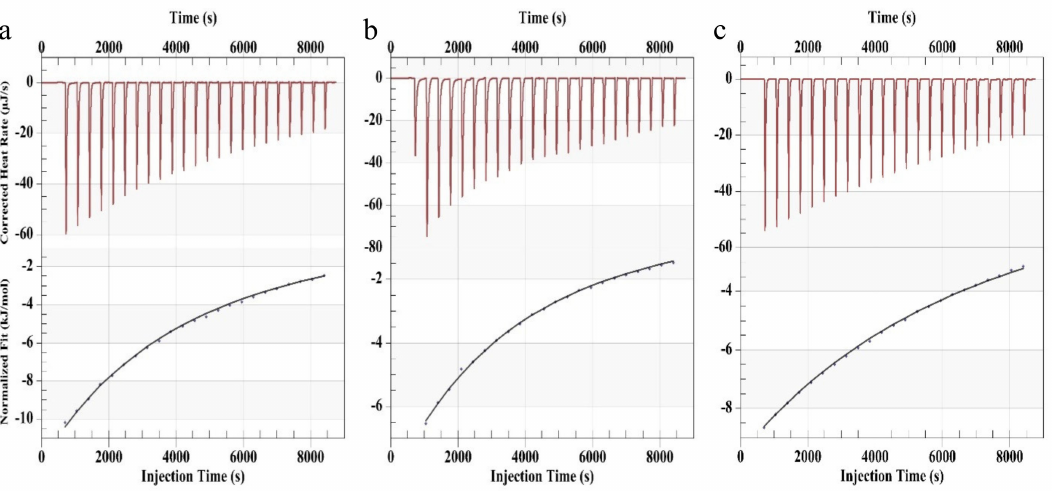
Figure 1. Isothermal titration calorimetry (ITC) curves of the titration of ( a ) Eu(NO 3 ) 3 · 5H 2 O, ( b ) Table 2. Summary of the complexation values after isothermal titration calorimetry of Eu(NO 3 ) 3 · 5H 2 O,